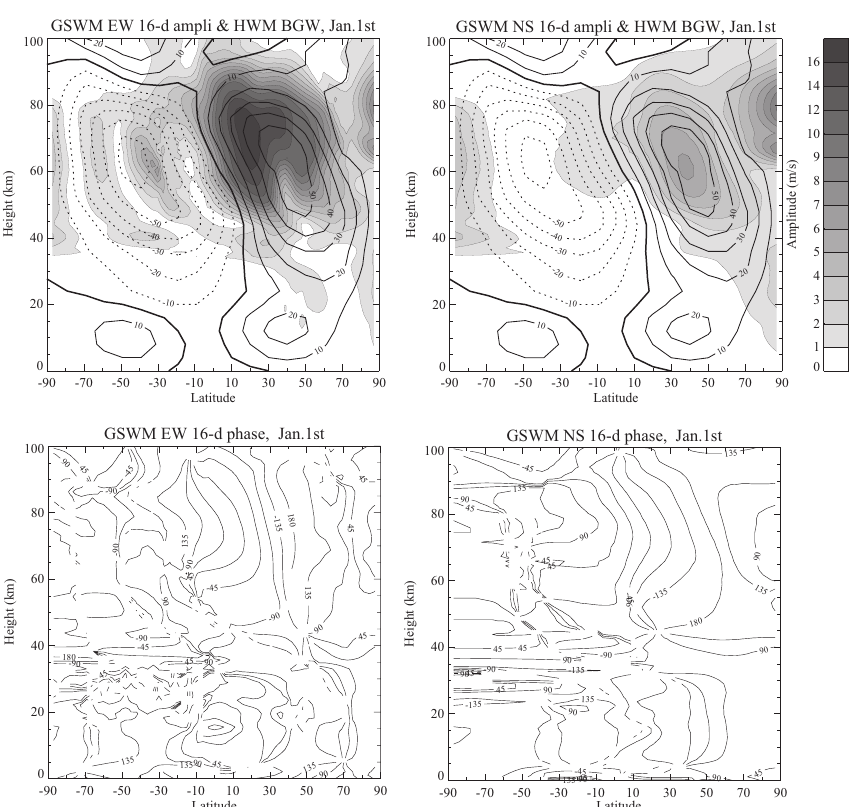
Fig. 7. The amplitudes and phases of the zonal and meridional wind 16-day perturbation from pole to pole obtained by the GSWM. Superimposed upon the amplitude grey contours are zonal background winds from the HWM93 with solid lines being the eastward. The model runs were under atmospheric conditions of 1 January. The unit of the wave amplitude and background wind is m/s. The phases are the wave amplitude crests in longitude degree and step by 45 ◦ .